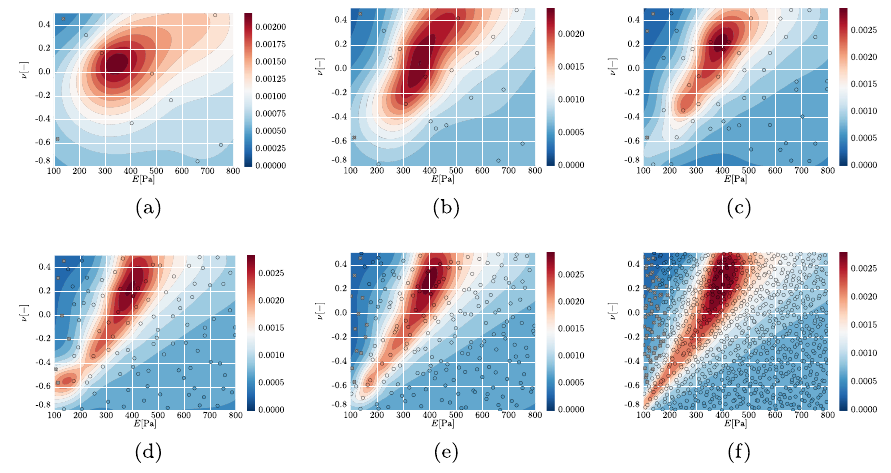
Fig. 8 Convergence of the Gaussian process regression model for the likelihood function over number of training points n train (forward model evaluations). a n train = 10, b n train = 20, c n train = 50, d n train = 100, e n train = 200, f n train = 900. In all cases the same Sobol sequence was used to generate a space-filling training data set. Training samples as circles for successful and gray crosses (left side) for failed forward model